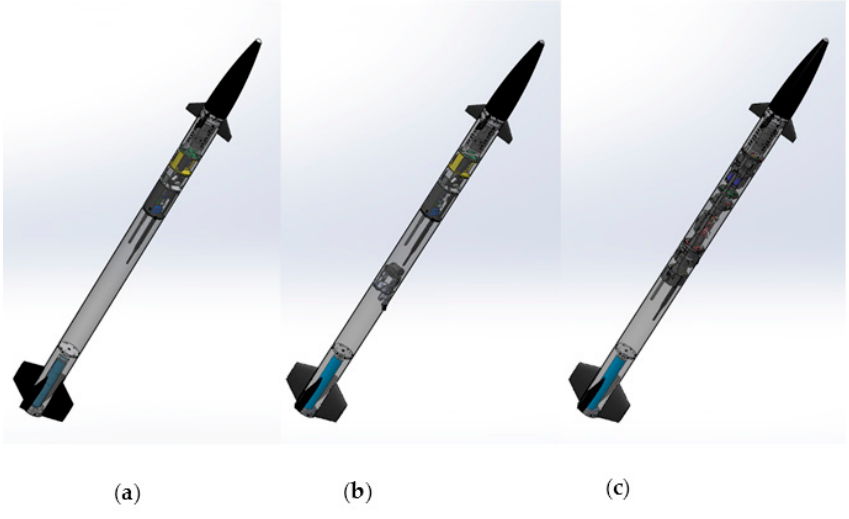
Figure 8. Improvements to airframe and avionics stack. ( a ) Smokey; ( b ) Tasha III, launch 1; ( c ) Tasha III, launch 2.